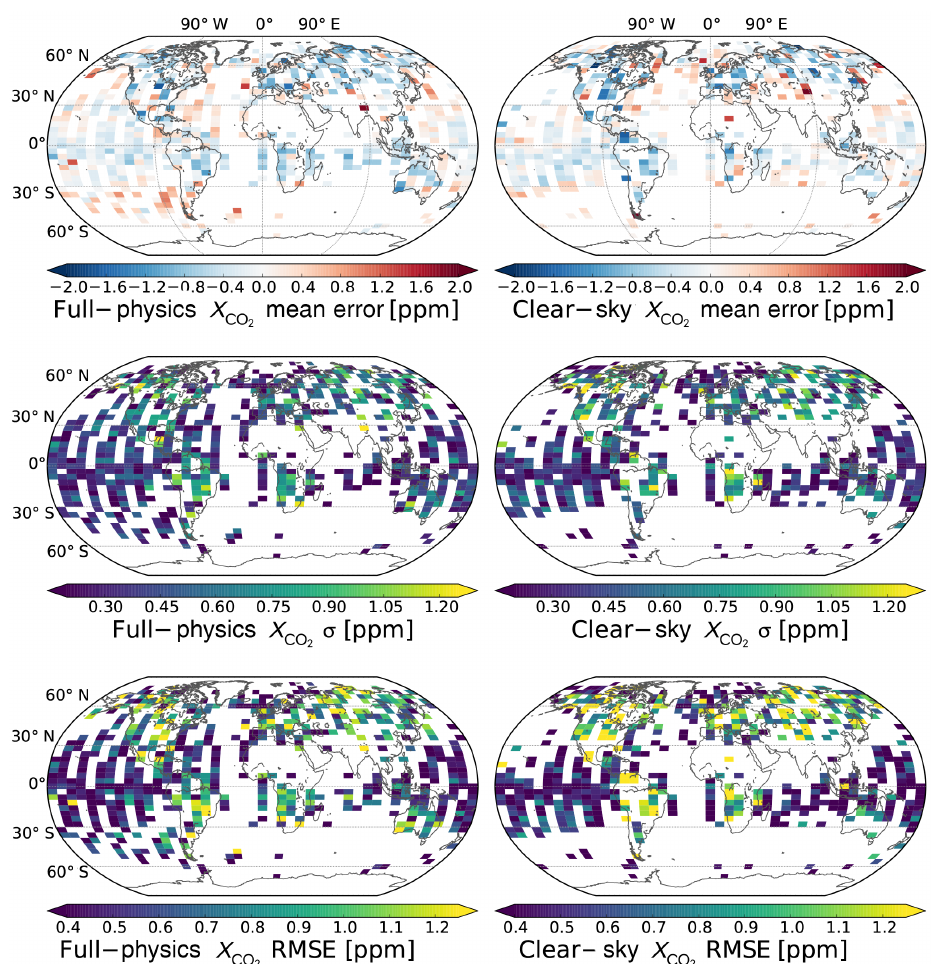
Figure 7. OCO-2 full-physics (left column) and clear-sky (right column) retrieval mean X CO X CO errors (middle row), and X CO RMSEs (bottom row) for 8 ◦ × 4 ◦ (longitude × latitude) bins for a throughput of 2 2